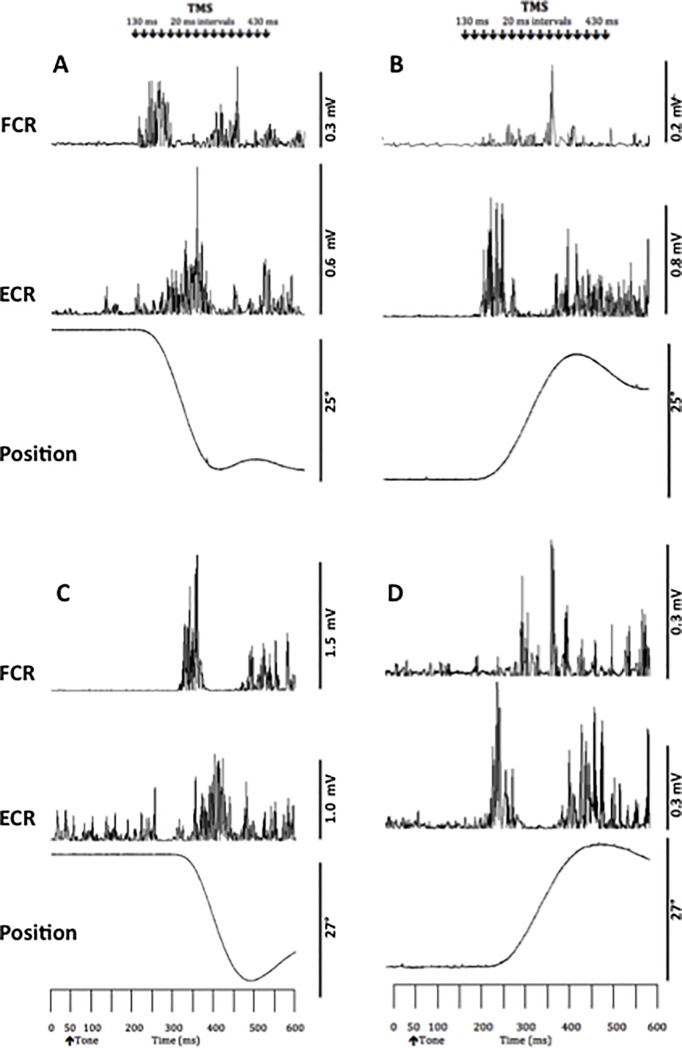
Typical recording.Representative example of rectified EMG activity of the flexor carpi radialis (FCR) and extensor carpi radialis longus (ECR) muscles during wrist flexion (A, C) and extension movements (B, D) in one young (A, B) and one old (C, D) subject. The lowest tracing within each panel is the wrist joint position data. Note the triphasic pattern of EMG activity associated with movements in both directions. The arrows at the top of the figure show the times when TMS was applied across. The auditory tone was presented at 50 ms.